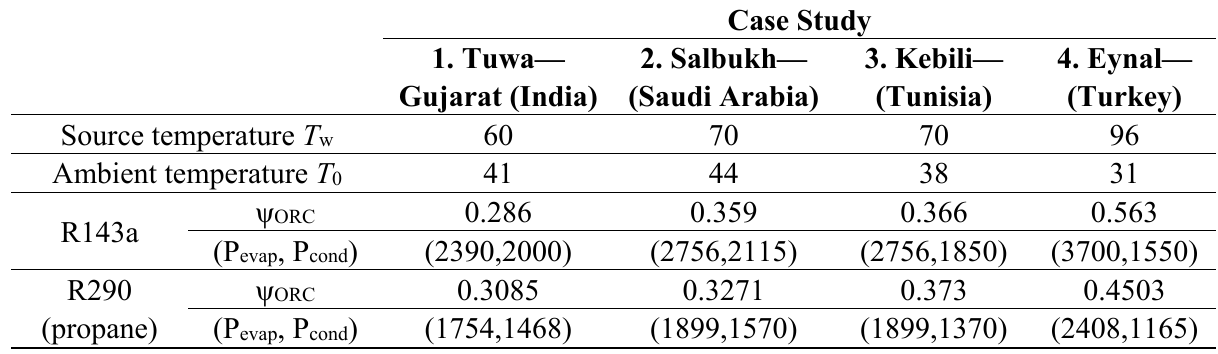
Table 5. Results for exergy efficiency ψ ORC as a function of the source and ambient temperatures for two working fluids (R143a and